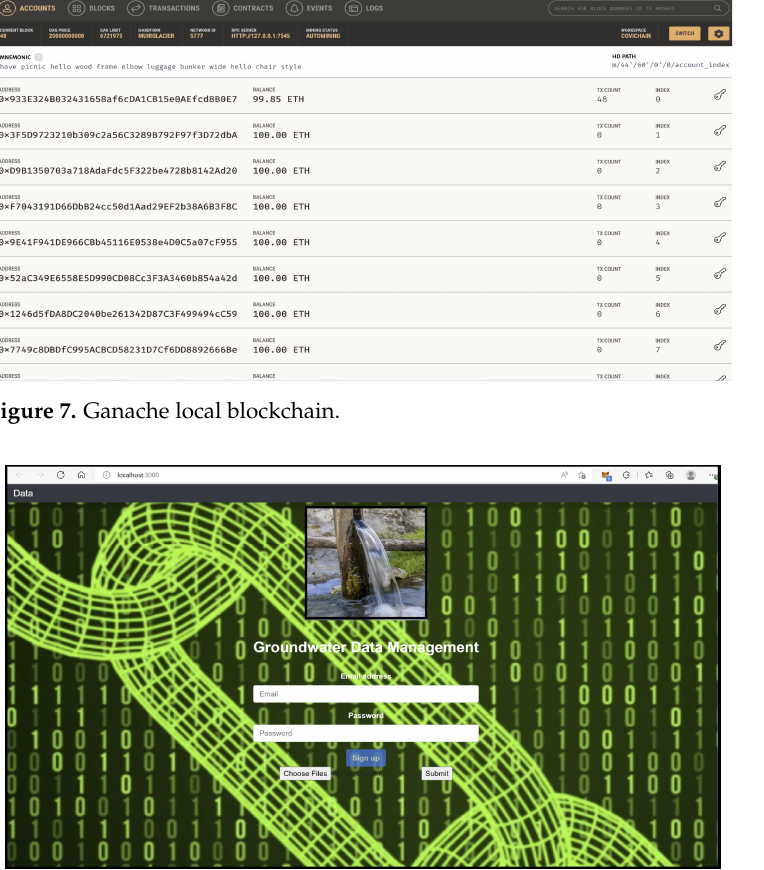
Figure 8. G-DaM User Interface.